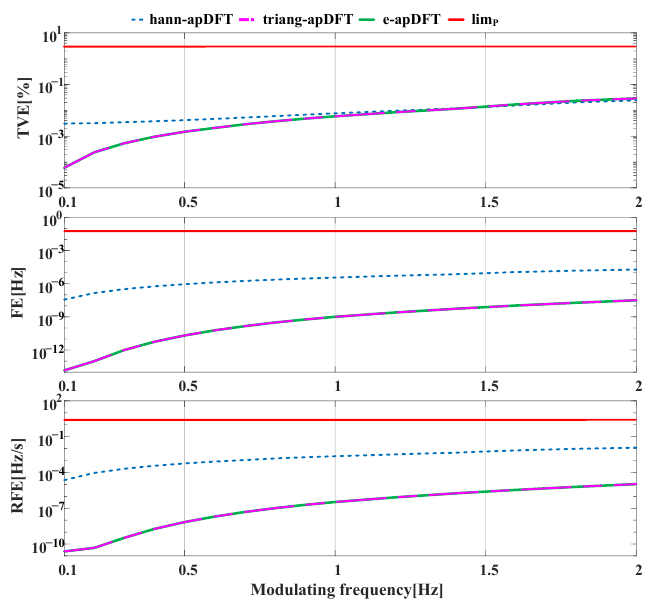
Figure 9. Amplitude modulation test.